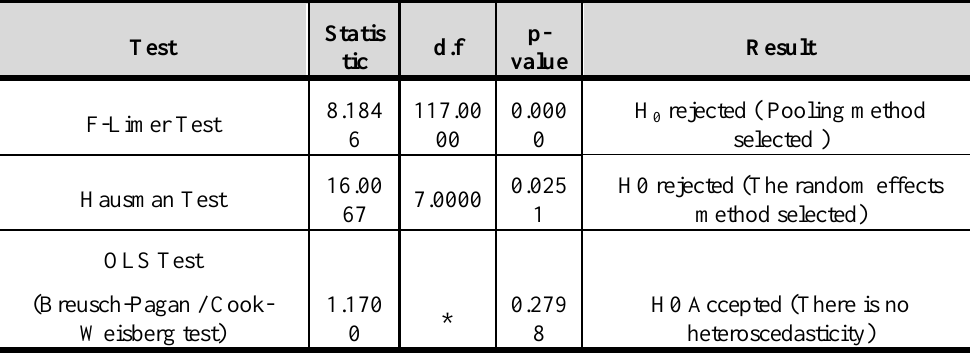
Table 3. The result of F-Limer, Hausman and OLS